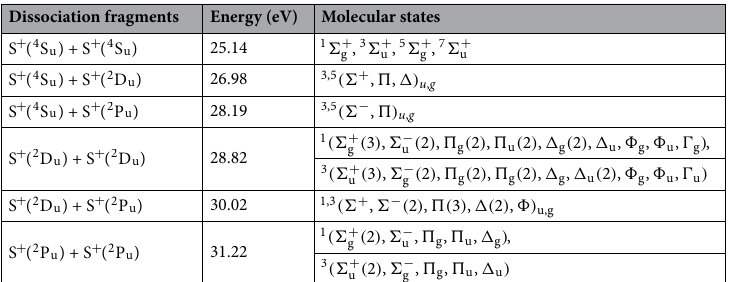
Dissociation fragments Energy (eV) Molecular states S + ( 4 S u ) + S + ( 4 S u ) 25.14